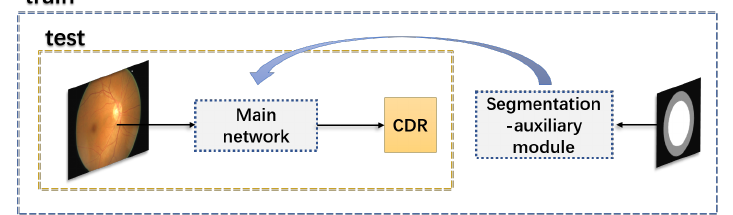
Figure 4. The segmentation-auxiliary task is introduced into our model which is parallel to the main regression task. During the test, our model works in an implicit way for which image segmentation information is considered but not